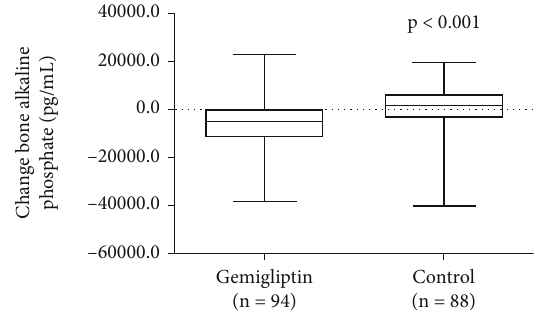
Figure 3: Changes in bone alkaline phosphatase in both groups at baseline and at the end of the